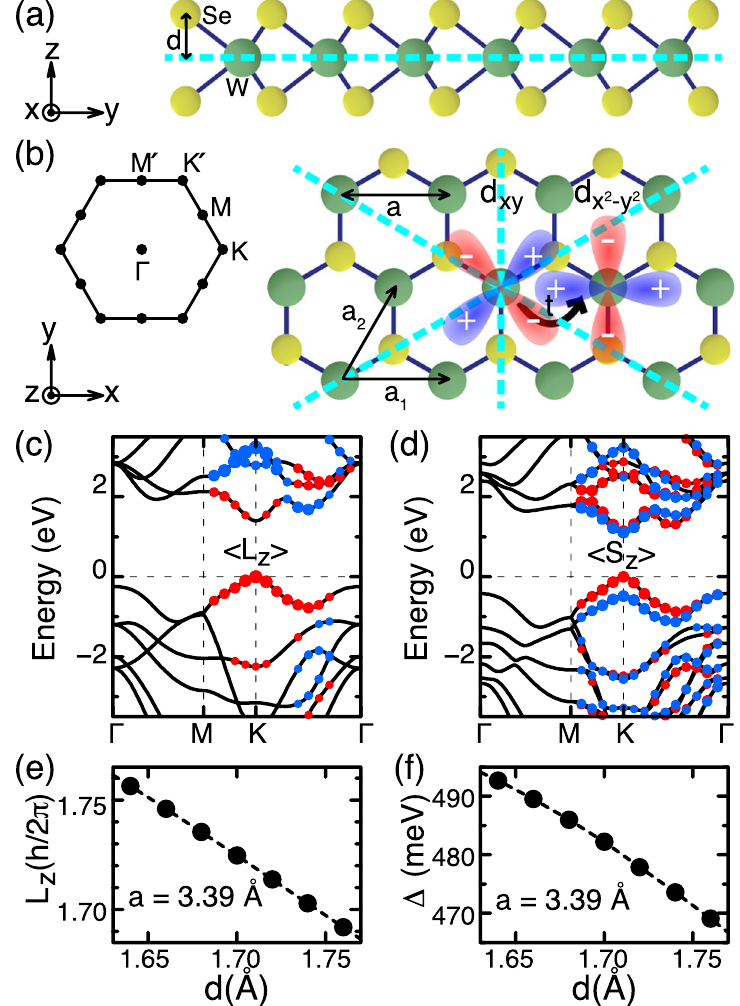
Figure 2. WSe 2 monolayer. ( a ) Side and ( b ) top view. Dashed lines are mirror planes. The interatomic hopping between d xy and − d orbitals of W atoms is nonzero in the x direction. The inset in ( b ) shows BZ, where the x y 2 2 Γ -K direction is along the x axis. ( c , d ) Electronic bands obtained ( c ) without SOI and ( d ) with SOI. The size of dots represents | 〈 L z 〉 | obtained without SOI in ( c ) and | 〈 S z 〉 | with SOI in ( d ), with blue for positive and red for negative values. ( e ) The OAM | 〈 L z 〉 |, without SOI, and ( f ) the spin splitting Δ , with SOI, of the valence band maximum at K versus the distance d between W and Se planes. For the pristine monolayer, d is 1.7